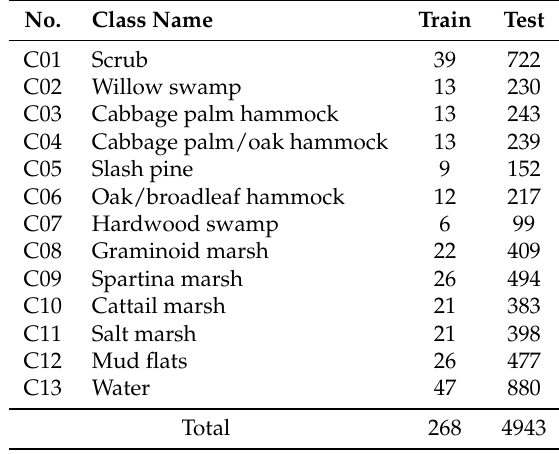
Table 2. The ground reference classes in the AVIRIS Kennedy Space Center dataset and the number of training and test pixels used in